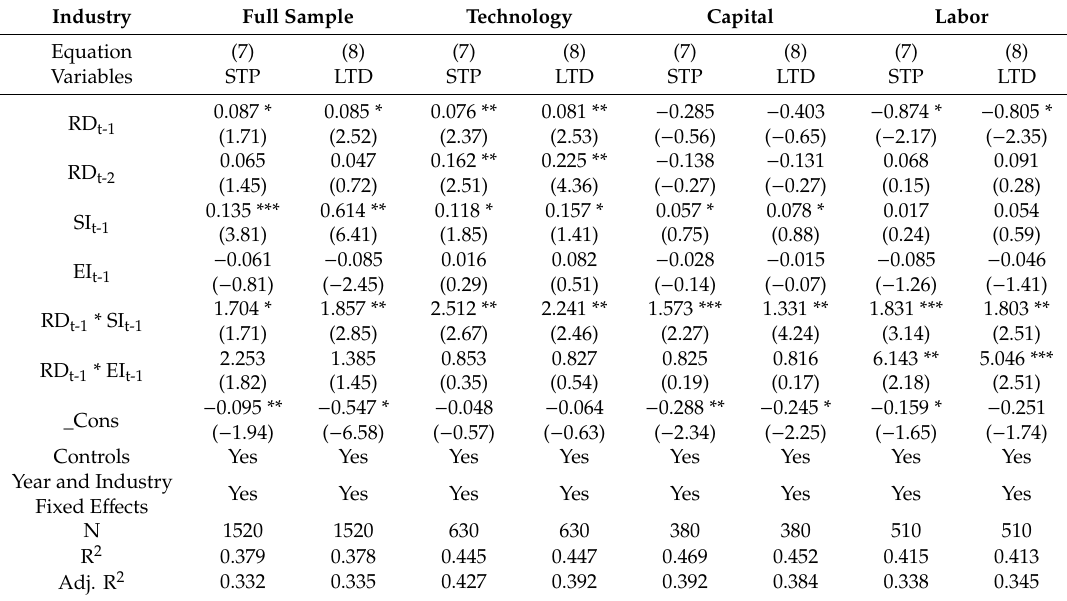
Table 8. The moderating e ff ect of executive incentive based on